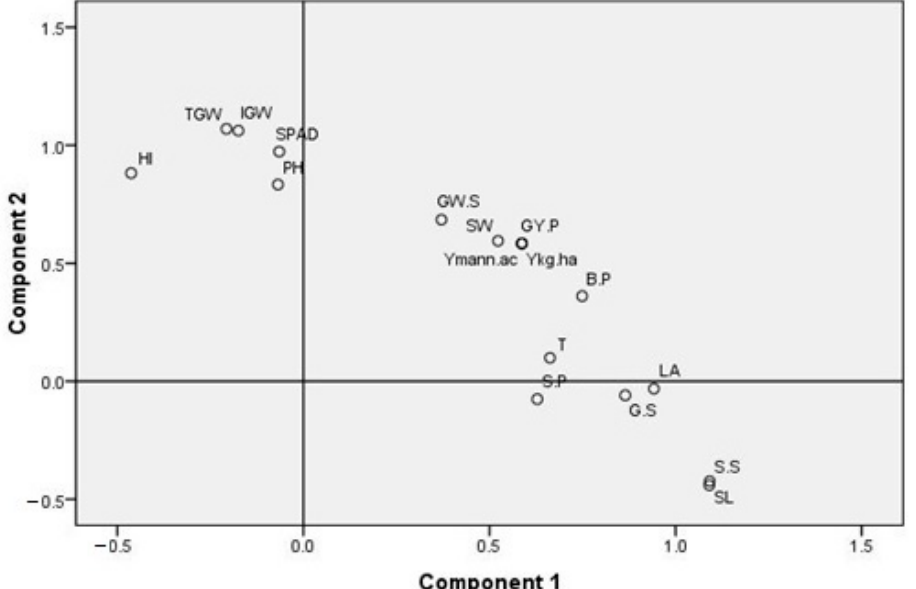
Figure 8. PCA plot showing chief components of plant stress responses. Note: PH: plant height; T: